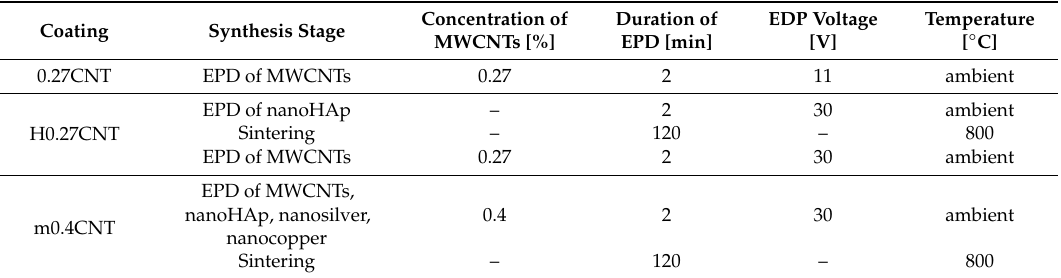
Table 2. Parameters of synthesis of the coatings with multi-walled carbon